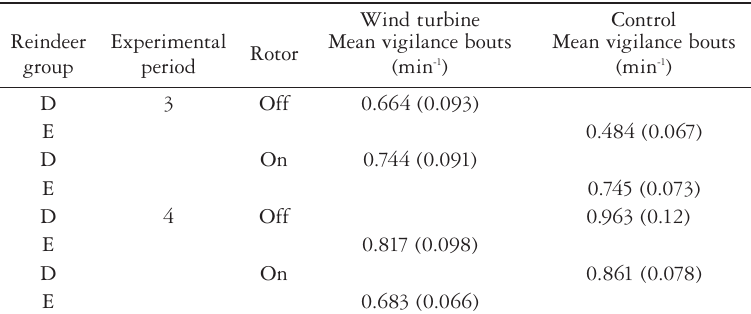
Table 2. The frequency min -1 (standard error of the mean ( s )) of vigilance bouts in rela- tion to enclosure, reindeer group and rotor movement, for period 3 and 4 in